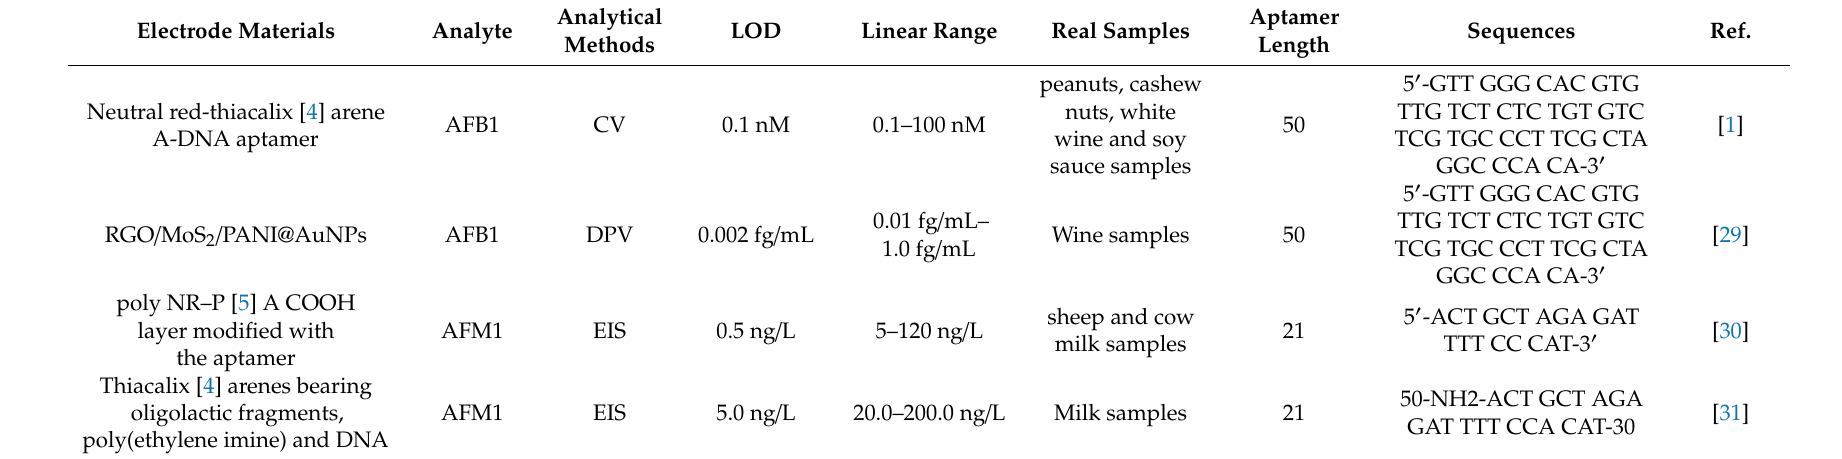
Table 1. Comparison of the e ffi ciency of glassy carbon electrode (GCE)-based aptasensors to detect aflatoxins